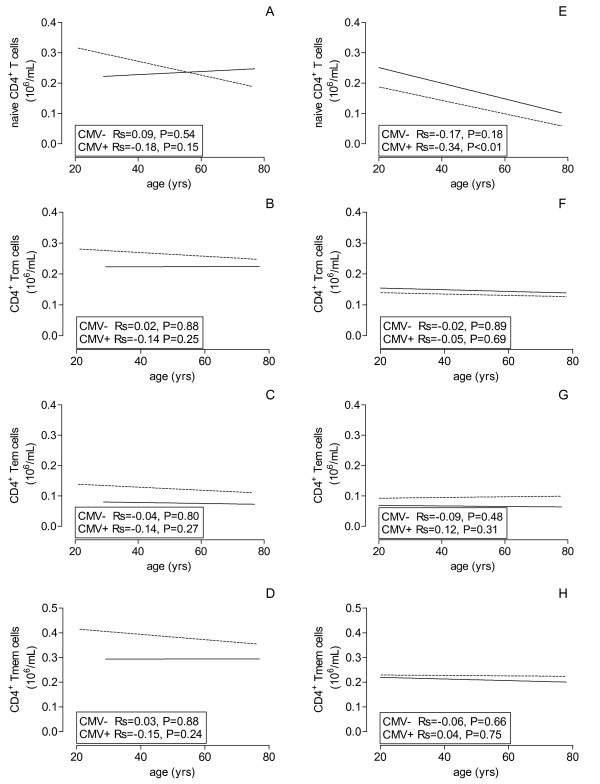
Age-related effects of CMV on CD4+ T cell subsets. The lines of the best fits are shown for absolute numbers of CD4+ Tnaive (A, E), Tcm (B, F), Tem (C, G) and Tmem (D, H) of healthy volunteers (A, B, C, D) and ESRD patients (E, F, G, H) against age on X-axis and CMV serostatus (dotted line = CMV seropositive and closed line = CMV seronegative).